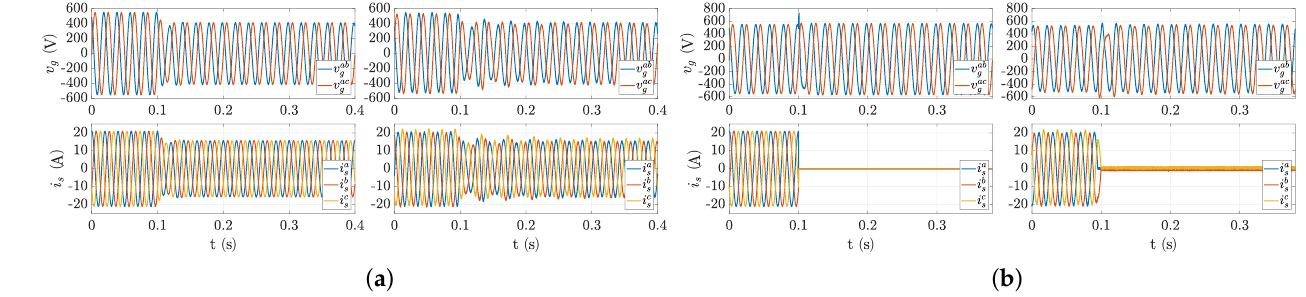
Figure 17. Simulation ( left ) and experimental ( right ) results, ( a ) showing AC grid voltage and current when a step change from 400 V to 300 V. ( b ) showing AC grid voltage and current when a resistance equivalent to the rated power (10 kW) is disconnected from the AC grid.